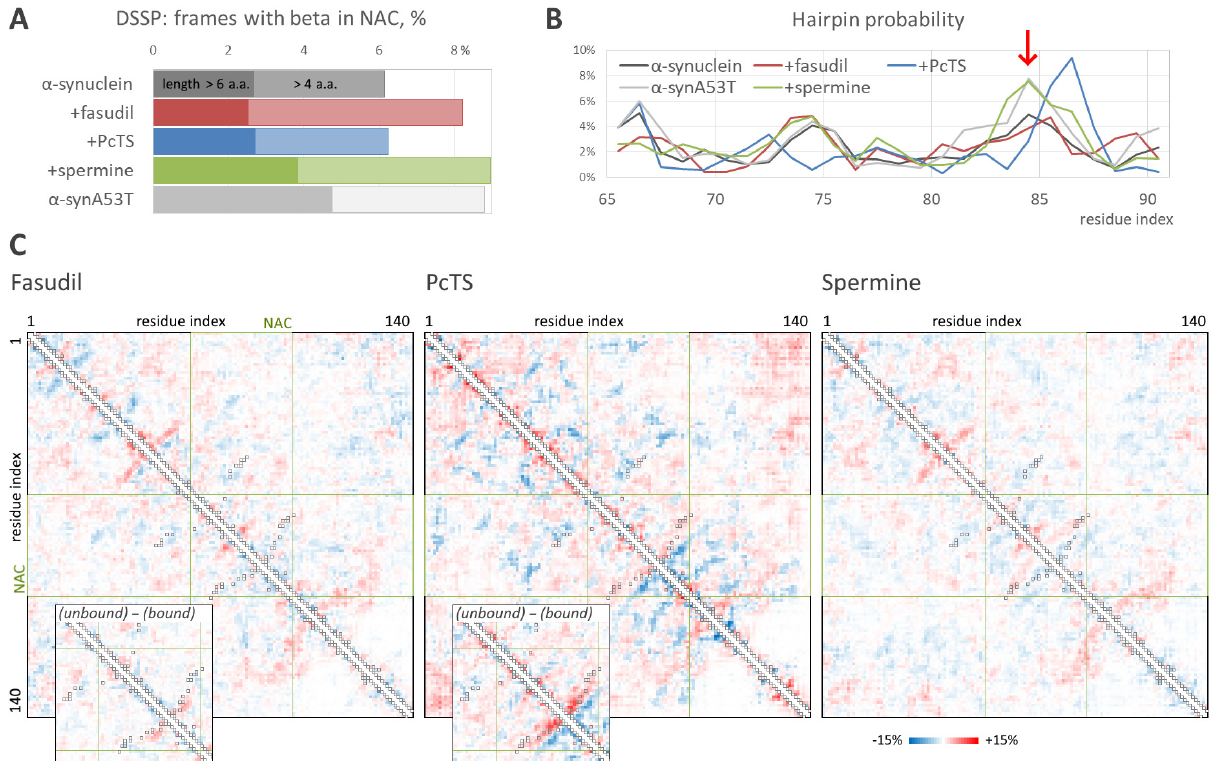
Figure 4. Propensity to form beta-hairpin. ( A ). Percentage of conformations with prolonged (dark and light colors shows values for a length threshold of 6 or 4 residues, respectively) beta-elements, according to DSSP, in the absence and the presence of the ligands as well as in the free mutant form, A53T. ( B ). Hairpin formation probability versus residue index in NAC-domain according to the distance from a reference beta-hairpin; red arrow indicates the hairpin position specific for fibrils. ( C ). Differential intramolecular contact maps obtained as the difference between contact maps for free alpha-synuclein ensemble and alpha-synuclein bound with the ligands; red and blue indicate contacts prevalent in the free form and the bound form, respectively. Insets show differences between the contact map fragments of alpha-synuclein unbound and bound with the ligand in an overall simulation ensemble for fasudil and PcTS. Black squares mark the contacts presented in the structure of alpha-synuclein fibrils, PDB ID 2n0a.